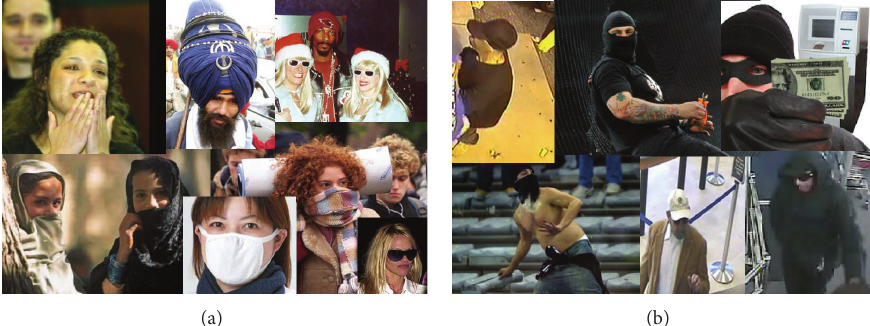
Figure 1: Illustration of different types of facial occlusions: (a) ordinary facial occlusions in daily life; (b) facial occlusions related to severe security issues (ATM crimes, football hooligans,